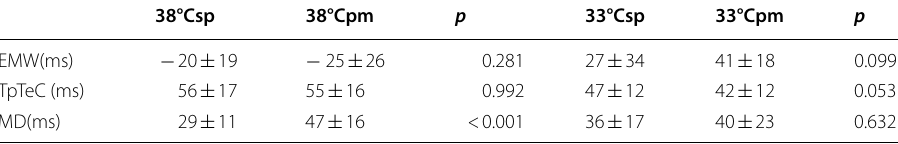
Data are expressed as mean